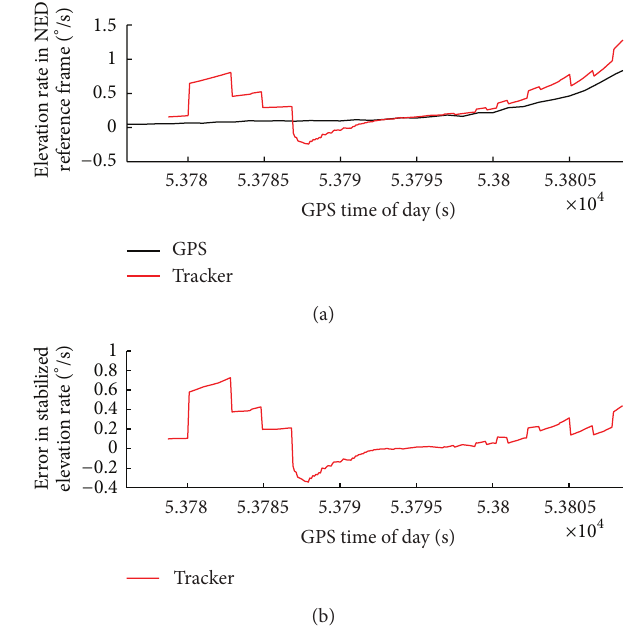
Figure 14: Intruder azimuth rate in NED (GPS and tracker) and relative estimation error (tracker with respect to GPS) as a function of GPS time in the considered scenario.